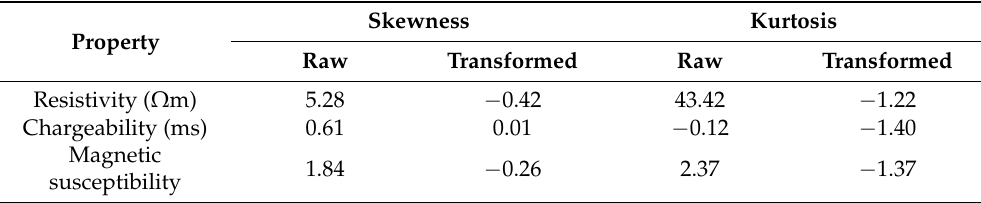
Table 1. Skewness and kurtosis values for the raw and transformed resistivity, chargeability, and mag- netic susceptibility data. Log transformation was applied to resistivity and magnetic susceptibility, and square root transformation to chargeability.